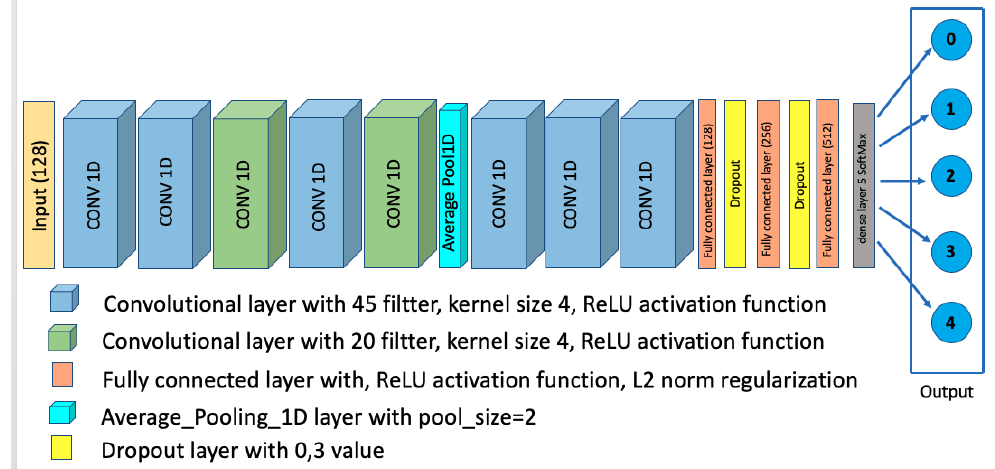
Figure 4. Proposed CNN